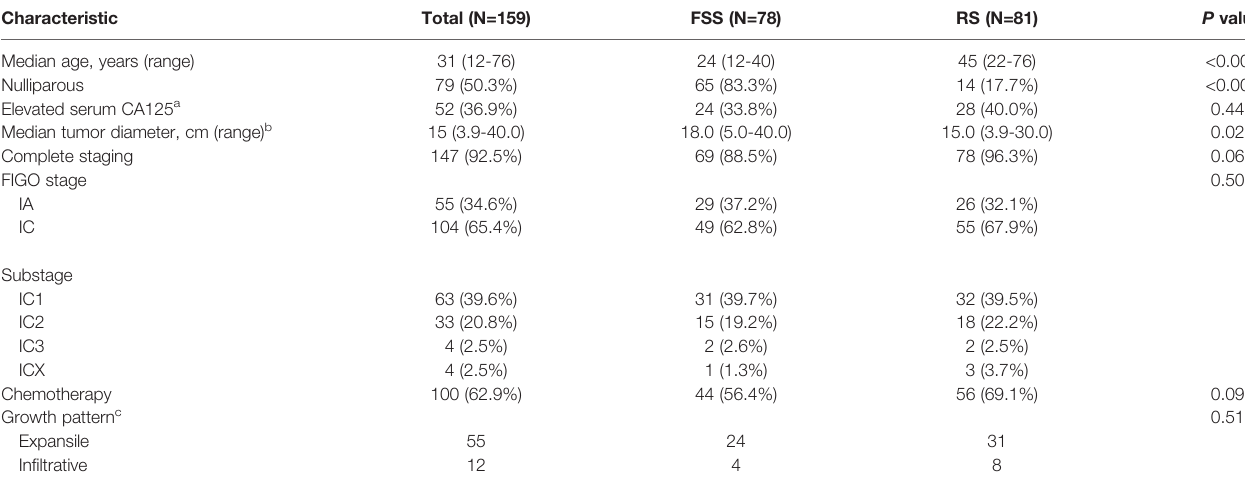
FSS, fertility-sparing surgery; RS, radical surgery. a Data are available in 141 patients. b Data are available in 147 patients. c Data are available in 67